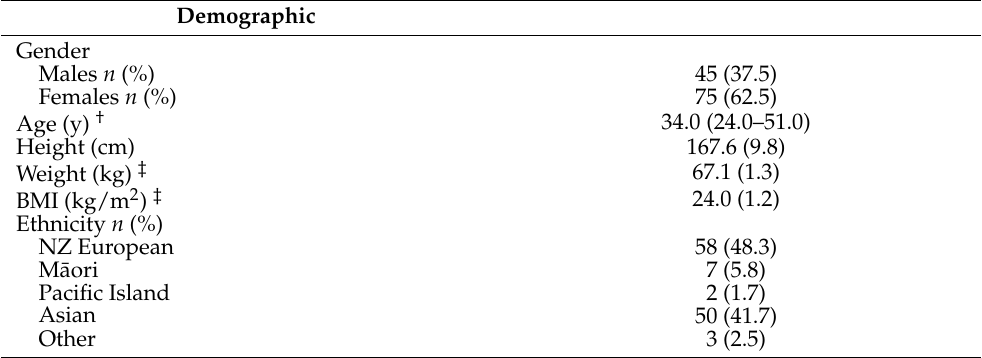
Table 1. Characteristics of study participants ( n =